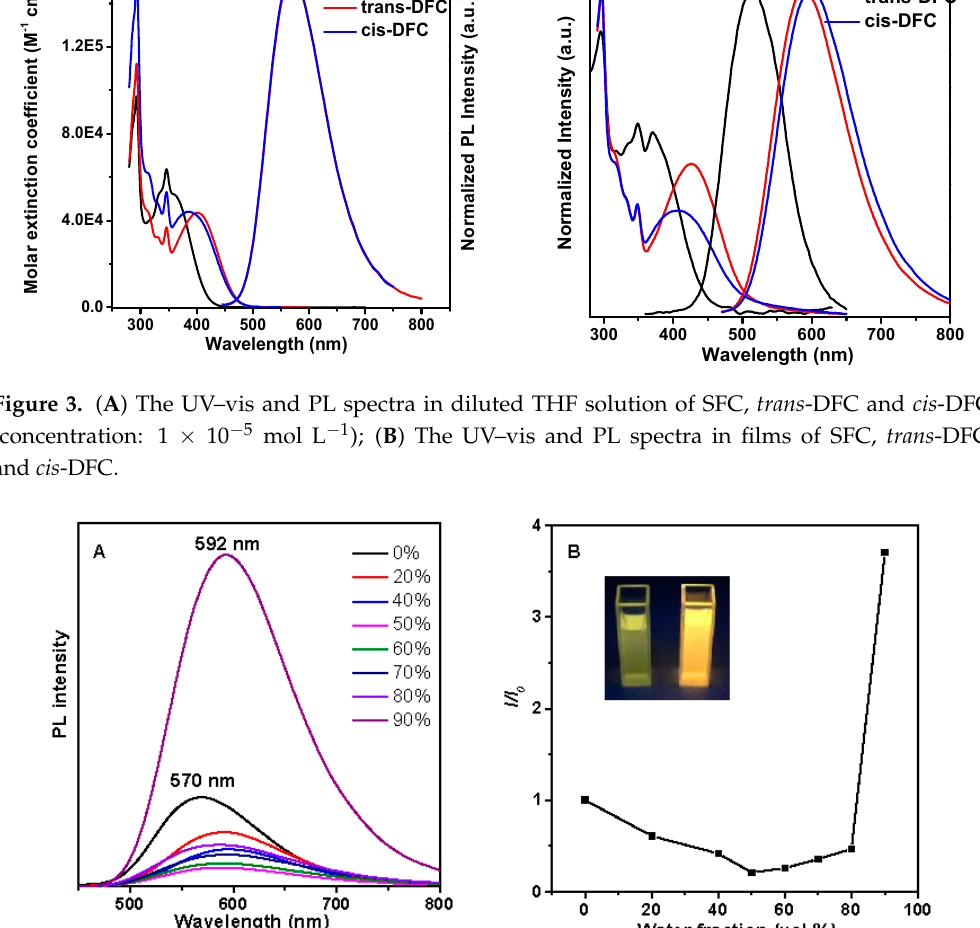
Figure 4. ( A ) PL spectra of trans -DFC in THF–water mixtures with different water fractions ( f w ); ( B ) Plot of the relative PL intensity ( I/I 0 ) versus the compositions of THF–water mixtures of trans -DFC. I 0 = emission intensity in pure THF solution. Inset in ( B ) are the fluorescent photographs at f w = 0 and 95% taken under a 365 nm UV lamp.